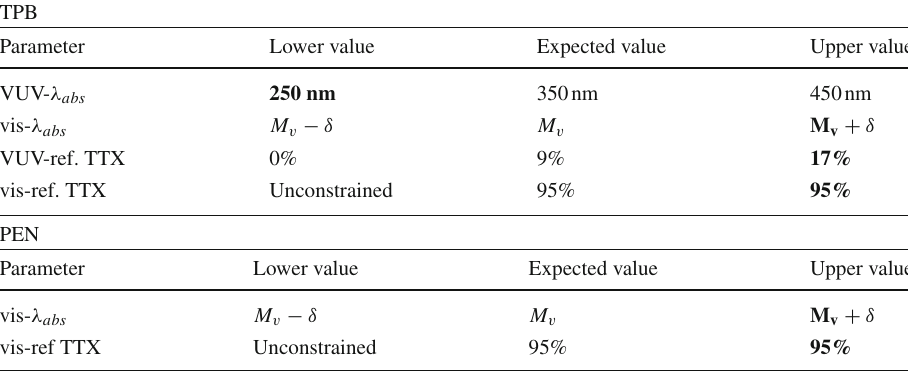
Table 4 Range of expected and limit values of the optical parameters of the WLSR samples given their uncertainties. The limit values used for the low limit case of QE are shown in bold. See text (Sect. 4.4.4) for